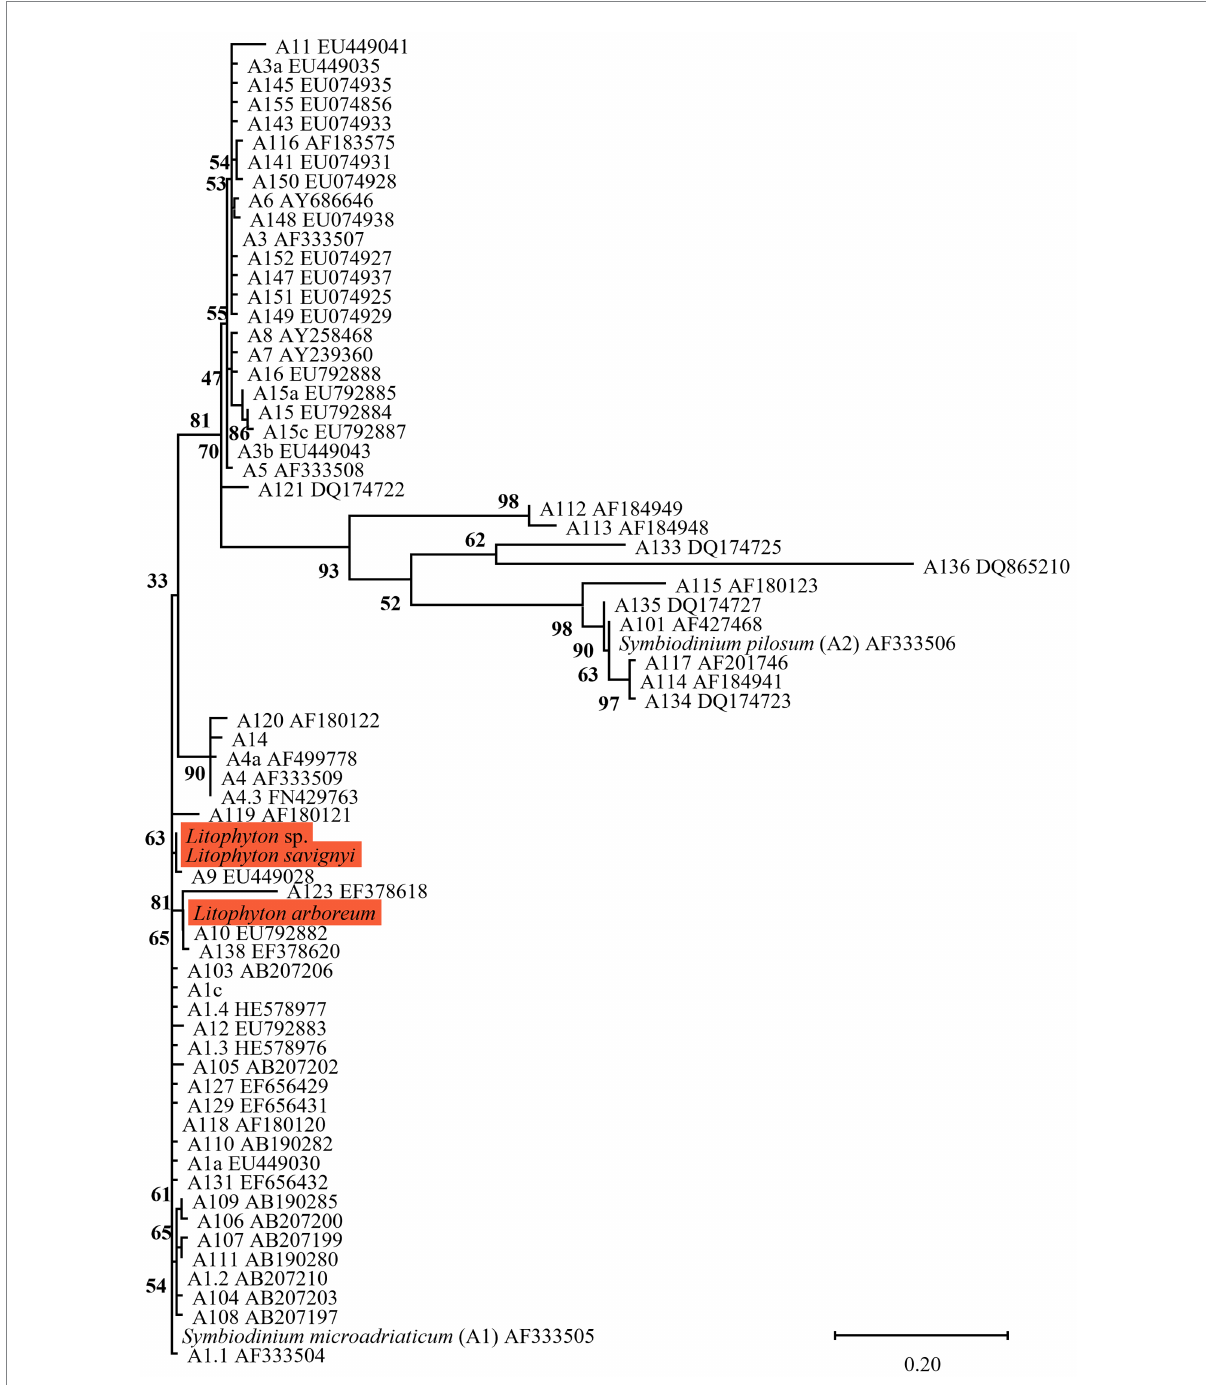
FIGURE 2 Phylogenetic relationship of the genus Symbiodinium (previously named clade A) based on ITS2 rDNA sequences (270 bp), under the K2P + G4 model. The maximum likelihood tree was reconstructed with IQ-TREE 2.1.3. ML bootstrap supports based on 1,000 replicates are indicated either above or below the corresponding branch. Orange color indicates new Symbiodiniaceae sequences that were obtained in the current study, for which the host name is indicated rather than the algal genetic